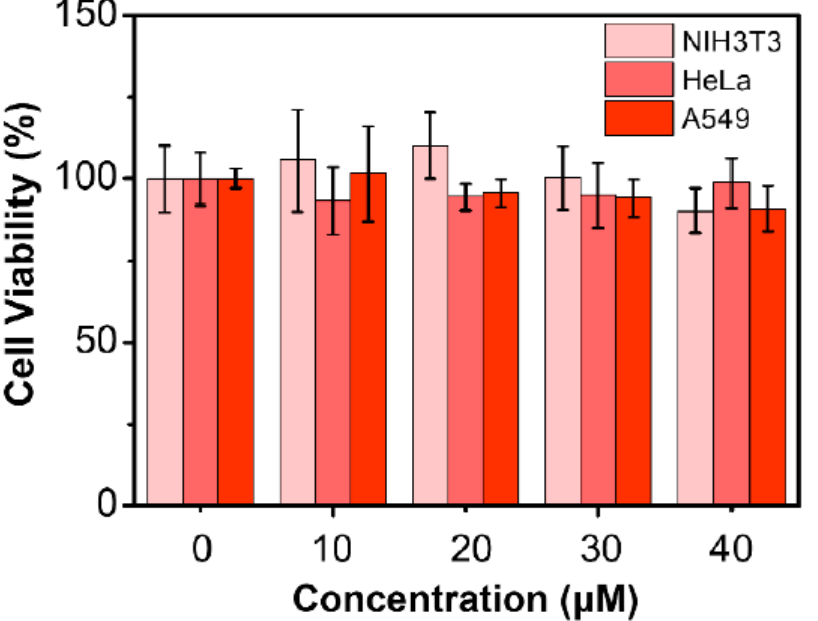
Figure 4. Cytotoxicity of probe 1 to NIH3T3, HeLa and A549 cells. Cells were incubated with various concentrations of probe 1 for 6 h, respectively. Error bars displayed mean ± standard deviation (s.d., n =